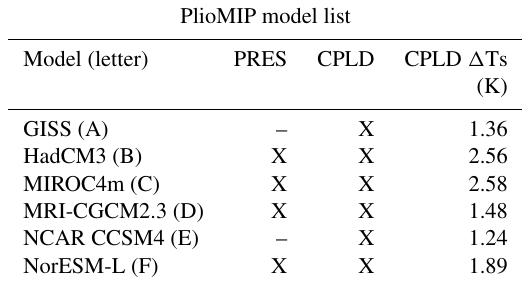
Table 1. The list of models available from PlioMIP for the pre- scribed SST (PRES) and coupled ocean–atmosphere (CPLD) exper- iments. The “X” (dash) indicates that the model data are available (unavailable). Two models in CPLD (GISS and NCAR CCSM4) do not have equivalents in PRES (we elected not to use data from NCAR CAM3.1 because it was not available for pressure levels). In the left column, the letter in parentheses after the model name shows its index in Fig. 6. The right column shows the tropical (30 ◦ S– 30 ◦ N) mean near-surface air temperature response ( (cid:49) Ts, unitsK) for each model in